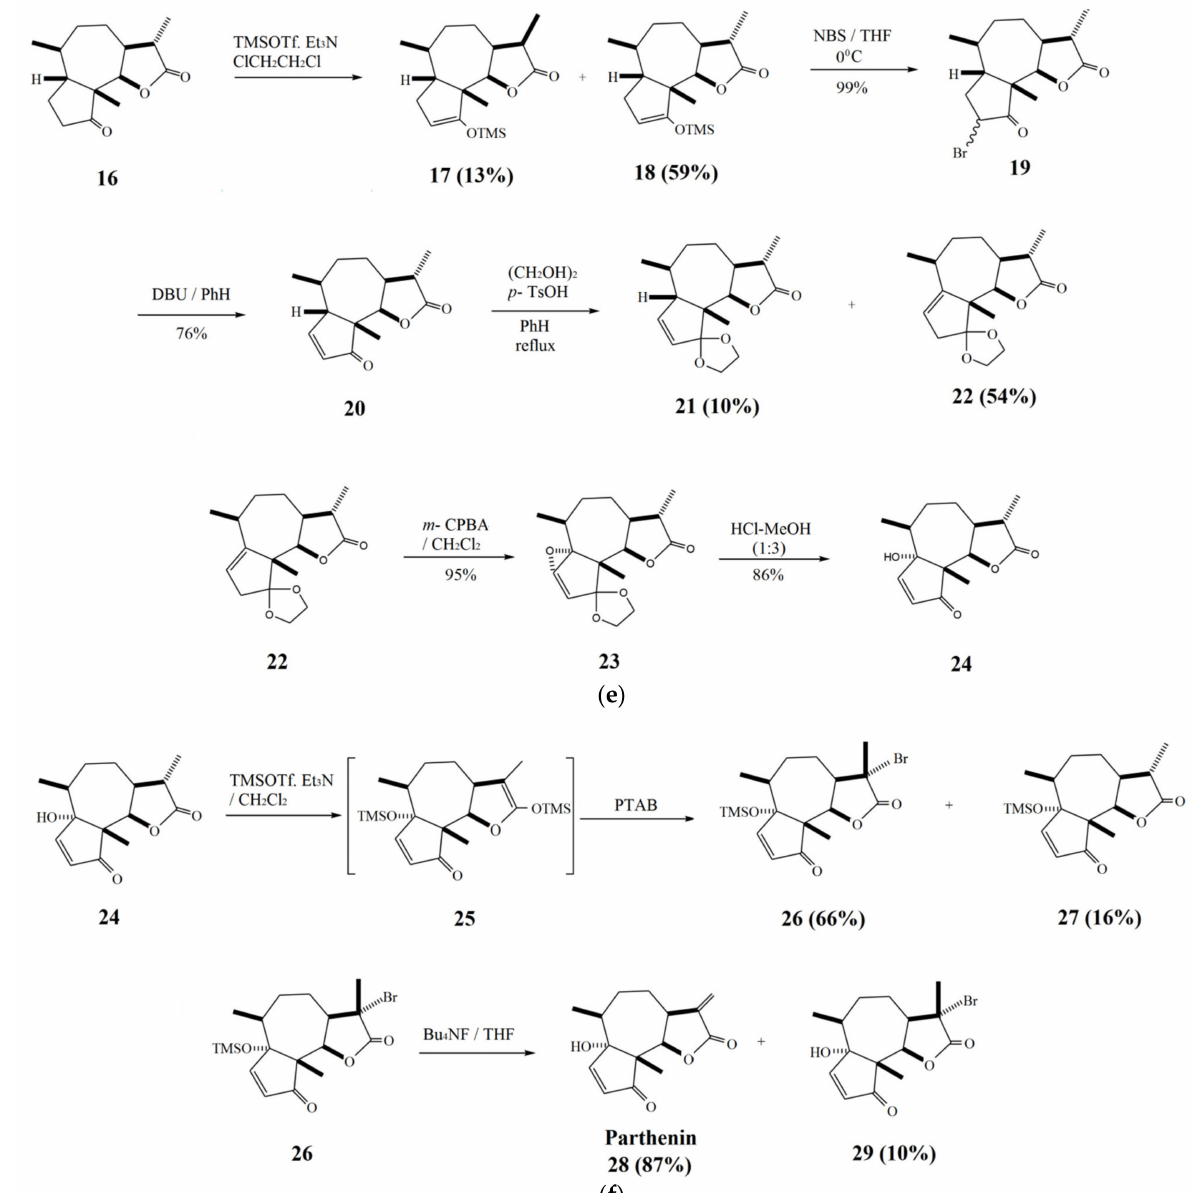
Figure 4. Synthesis of parthenin by the method provided by Shimoma et al. [24]. Compounds: 4-methyltropolone ( 1 ); ethyl 8-hydroxy-6-methyl-2-oxo-2 H -cyclohepta[ b ]furan-3-carboxylate ( 2 ); cycloheptenol derivative ( 3 ); α , β -unsaturated ketone ( 4 ); Grignard reagent ( 5 ); α -oriented acetal ( 6 ); diastereomers ( 7 , 8 ); benzoates ( 9 ); intermediary aldehyde ( 10 ); aldol product ( 11 ); benzoates ( 12 ); aldehyde product ( 13 ); triol ( 14 ); γ -lactone alcohol ( 15 ); ketolactone ( 16 ); C-3 epimer ( 17 ); silyl enol ether ( 18 ); α -bromo ketone ( 19 ); α , β -unsaturated ketone ( 20 ); α , β -unsaturated ketal ( 21 ); ketal product ( 22 ); intermediate product ( 23 ); hymenolin ( 24 ); silyl enol ether ( 25 ); α -bromolactone ( 26 ); α -methyl- γ -lactone ( 27 ); parthenin ( 28 ); and 11 α -bromo hymenolin ( 29 ). ( a ) Formation of the key intermediate 3 from 4-methyltropolone ( 1 ) through another intermediate ( 2 ); ( b ) oxidation of 3 , followed by addition of Grignard reagent resulted in the formation of enone ( 6 ), methylation of which gave the intermediate 7 and its epimer 8 ; ( c ) intramolecular aldol condensation of the intermediates 7 and 8 resulted in another intermediate 11 ; ( d ) intermediate 11 is subjected to a reduction, forming triol 14 , which is then oxidised to yield 16 through 15 ; ( e ) formation of the final intermediate, α -methylene- γ -lactone hymenolin ( 24 ) via lactonisation, oxidation, several protection/de-protection steps, dehydrogenation, epoxidation, and hydrolysis of 16 ; and ( f ) hymenolin ( 24 ) is converted to parthenin ( 28 ) via α -bromination and